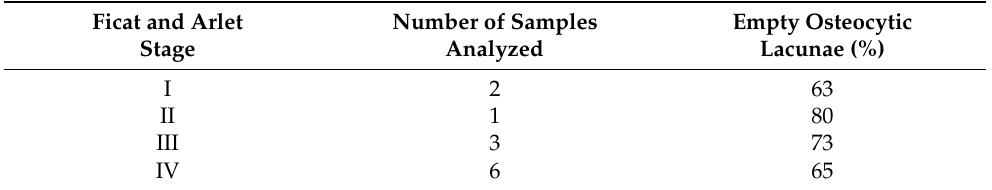
Table 3. Data comparing Ficat and Arlet imaging stage and the average number of empty osteocytic lacunae in our ONFH